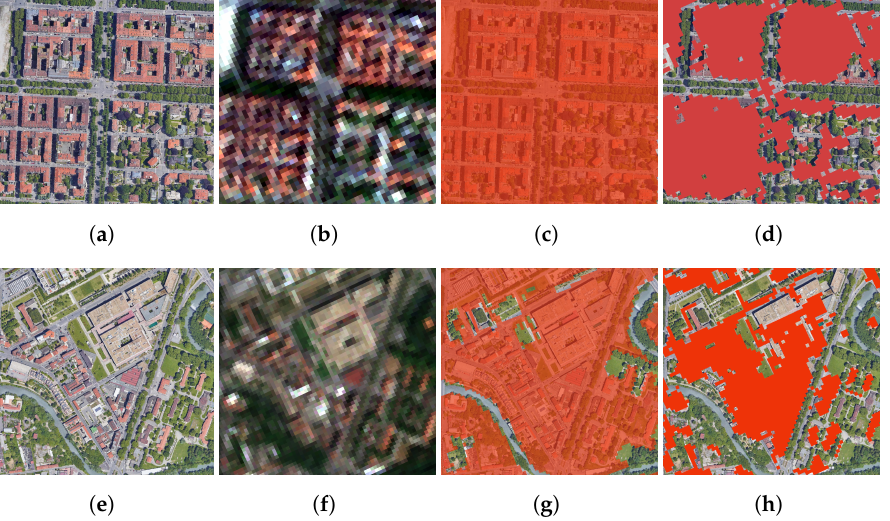
Figure 12. Semantic mapping with ReFuse model for two areas in the city of Turin. ( a , e ) Optical images extracted from Google Earth. ( b , f ) Sentinel-2 RGB images. ( c , g ) Ground truth extracted from ISPRA Soil consumption map. In red, imperviousness surfaces. ( d , h ) Predicted maps with the ReFuse model. Despite errors in the ground-truth labels (see image ( c )), the network correctly detects the green infrastructure within the area, i.e., trees, grass and parks (see image ( d